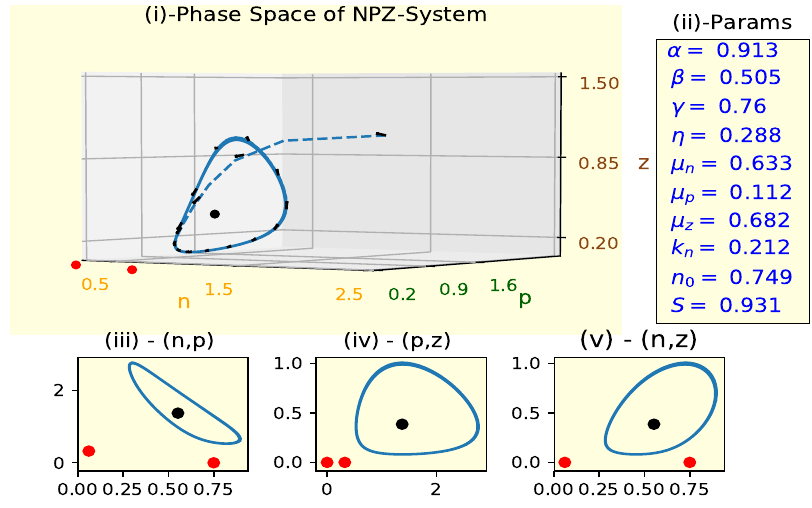
Fig. 8: (i)-Emerging limit cycle after the Hopf bifurcation. It is the convergence of 11 trajectories after a transient time of 8000 . The black point indicates the unstable internal equilibrium.(ii)-System Parameters . (iii), (iv) and (v) are respectively the projections of cycle on planes (n,p), (p,z) and (n,